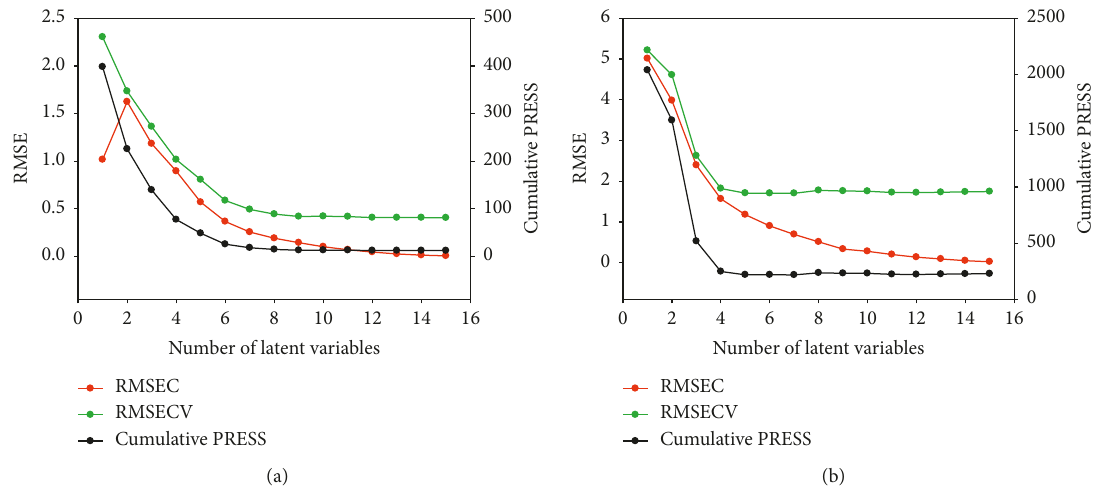
Table 3: The validation results for NIR determination of cryptotanshinone .